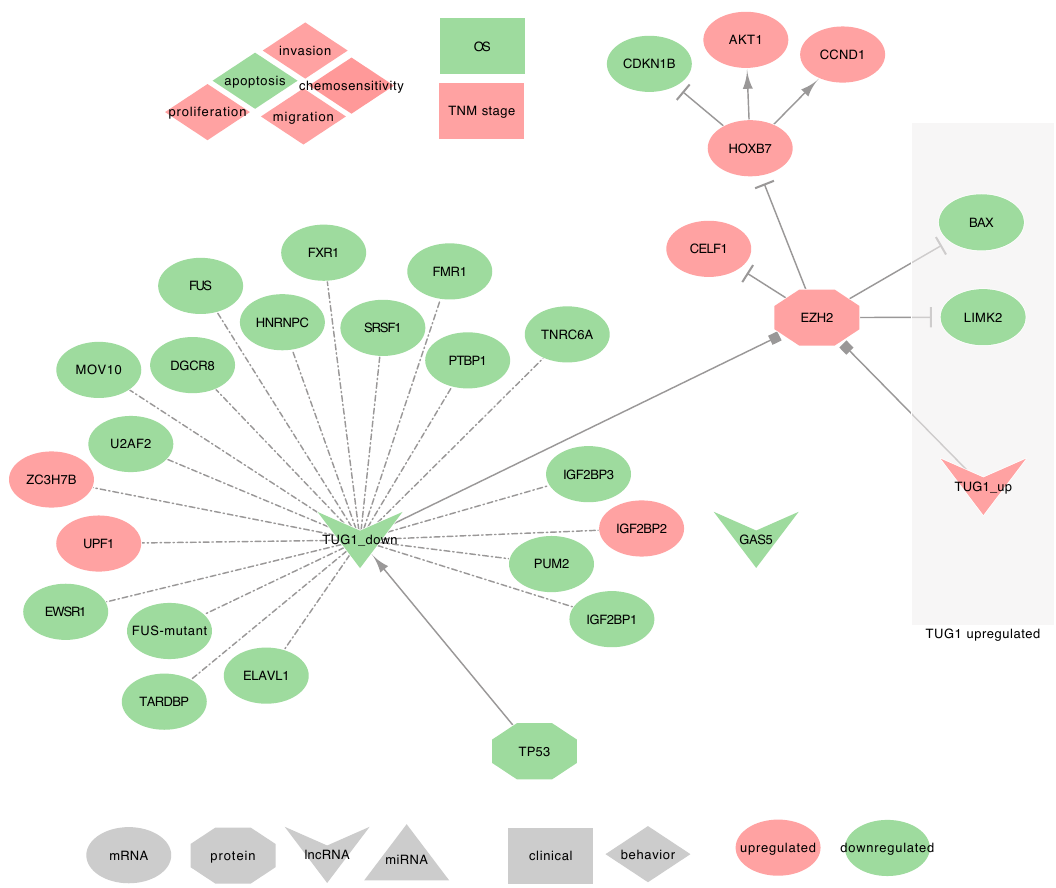
Figure 9. TUG1 in lung cancers: A network of lncRNA-miRNA-Protein interactions. Upregulated molecules are in green. Downregulated molecules are in red. Shape definitions are in grey. Gray arrows target the activated molecules. T-ended lines target the inhibited molecules. Square-ended lines represent a binding between molecules. Dashed-dot lines represent an association with unknown